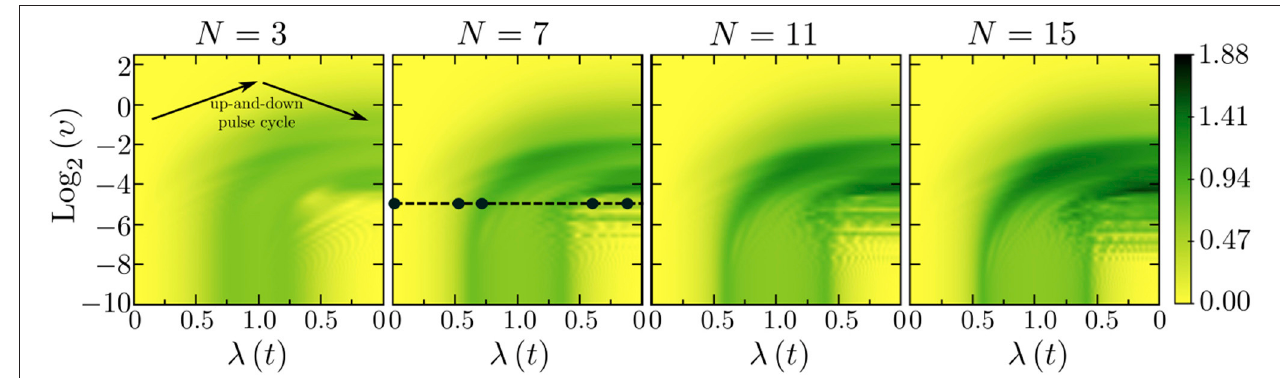
FIGURE 2 | Collective quantum coherence generated by a simple up-and-down pulse [i.e., triangular λ ( t ) indicated in first panel], as measured by the von Neumann entropy which quantifies the quantum entanglement between the electronic and bosonic (e.g., vibrational) subsystems. By the end of just one up-and-down cycle for a broad range of intermediate return trip times, a substantial amount of quantum coherence is generated in the N -component system for general N . If the external perturbation is then turned off, for example because the pulse has ended, the generated coherence will survive as long as the built-in decoherence/dephasing mechanisms in the sample allow it to last. The darker the color, the larger the quantum coherence (see color bar). The larger the υ , the less negative the logarithm (i.e., higher on the vertical scale), and the shorter the return trip time. Since these results look qualitatively similar for any N coherences observed empirically in chemical and biophysical systems [4]. Increasing N simply increases the numerical value of the peak value, while choosing a smaller λ ( t ) maximum just reduces the magnitude of the effect. The five points indicated along the horizontal dashed line for N values of time at which the sub-system Wigner functions are evaluated in the next